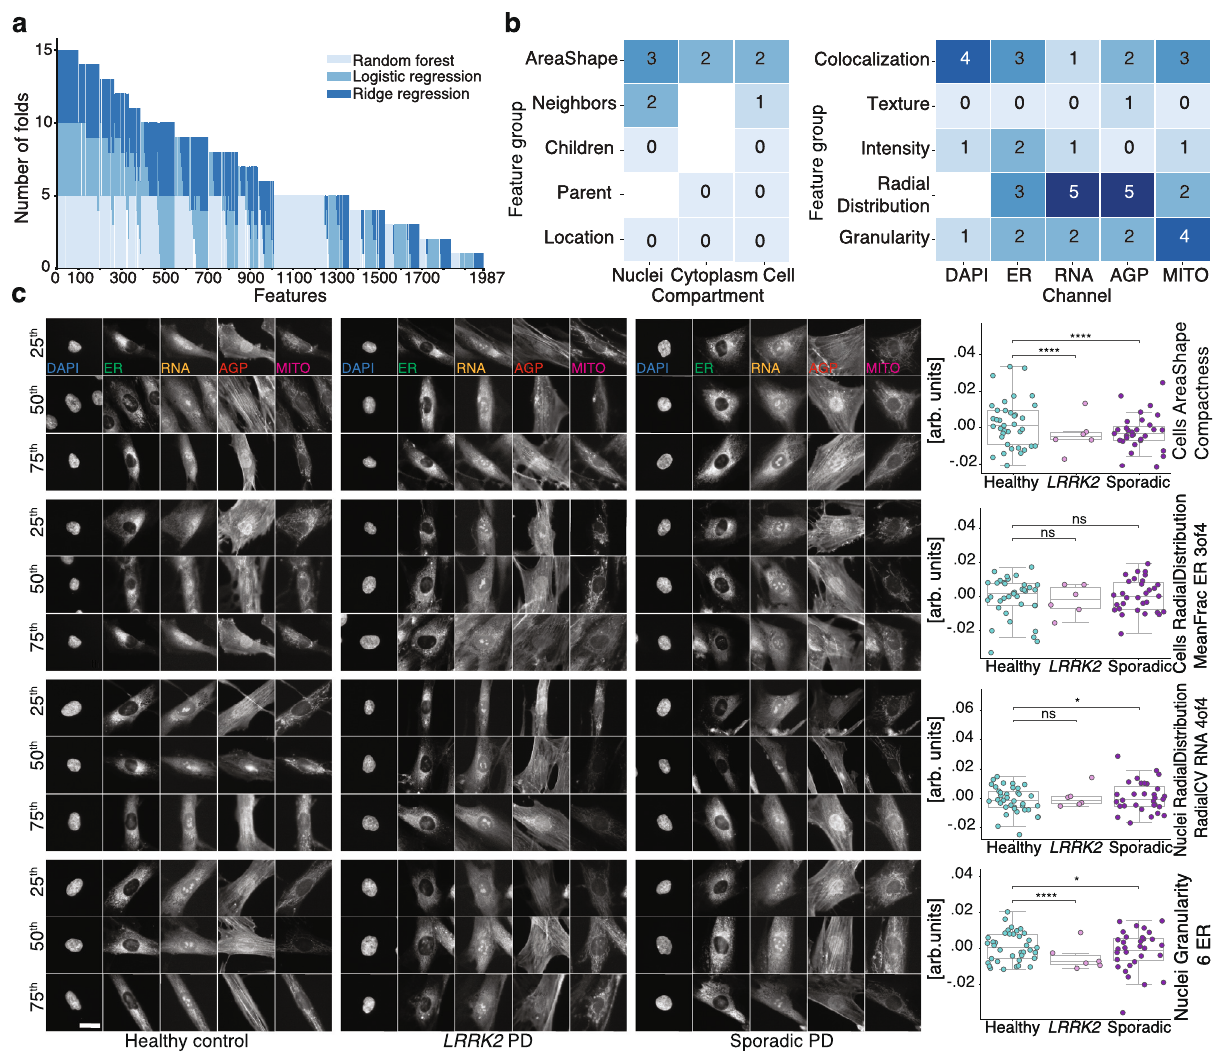
Fig. 6 PD classi fi cation is driven by a large variety of cell features. a Frequency among 5 cross-validation folds of 3 models where a CellPro fi ler feature was within the 1200 most signi fi cant of the 3483 features reveals a diverse set of features supporting PD classi fi cation. b Frequency of each class of Cell Painting features of the 100 most common features in a , with correlated features removed. c Images of representative cells and respective cell line – level mean ( n = 74 individuals, over all 4 batches) feature values (points and box plot; point colors denote disease state) for 4 features randomly selected from those in b . Cells closest to the 25th, 50th and 75th percentiles were selected. Scale bar: 20 μ m. Box plot components are: horizontal line, median; box, interquartile range; whiskers, 1.5× interquartile range. arb. units: arbitrary units. Two-sided Mann – Whitney U test: ns: P > 0.05; *0.01 < P ≤